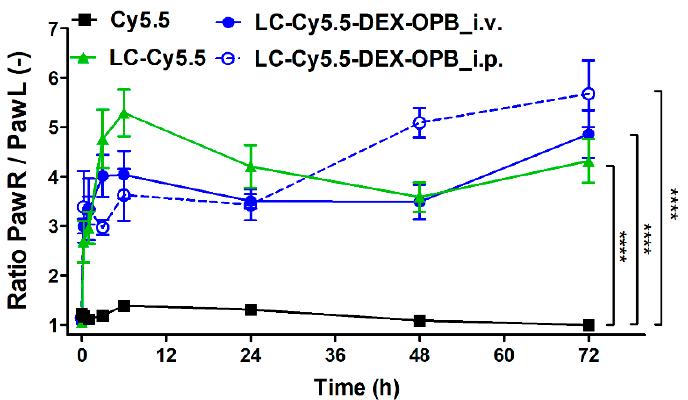
Figure 4. In vivo fluorescence data. The ratio of the arthritic right paw fluorescence to the healthy left paw fluorescence of the free fluorescent dye (Cy5.5), the fluorescently labeled linear copolymer (LC-Cy5.5) and fluorescently labeled linear copolymer conjugated to the ester of dexamethasone injected either i.v. (LC-Cy5.5-DEX-OPB_i.v.) or i.p. (LC-Cy5.5-DEX-OPB_i.p.). Injection of the 0.1 mg Cy5.5 eq/kg, n = 6.